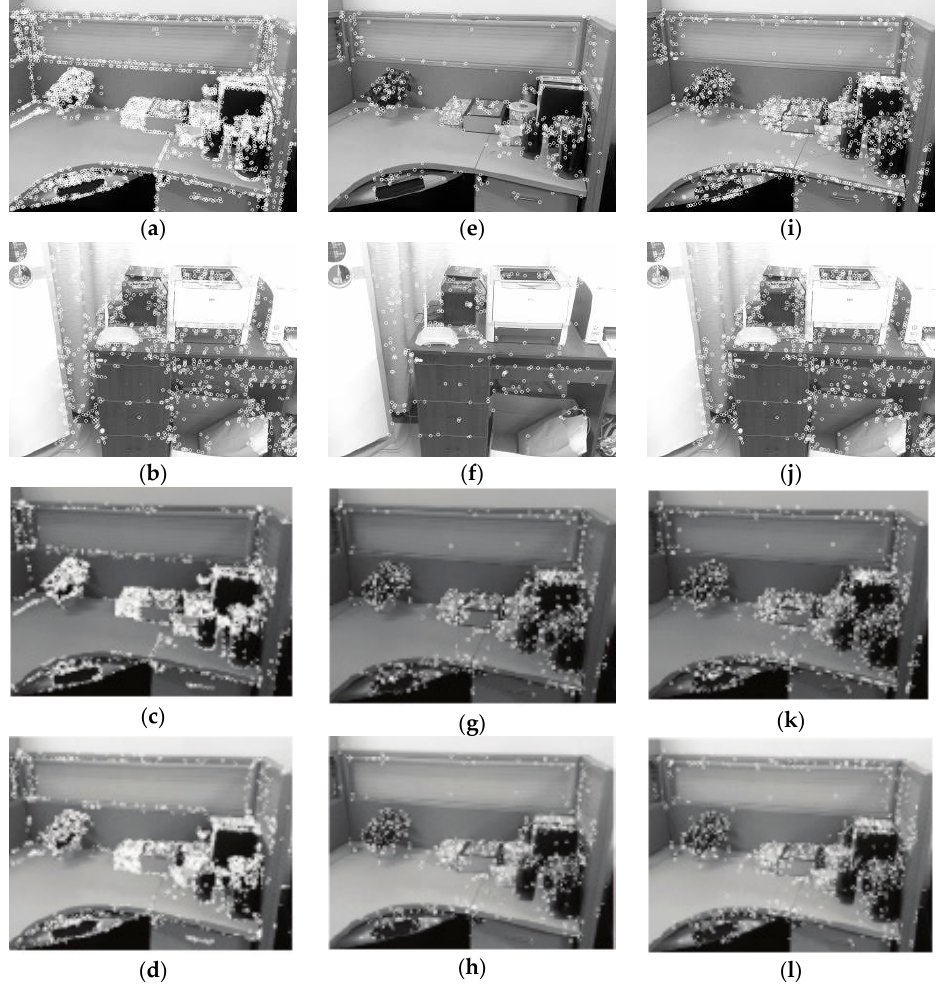
Figure 6. Feature points extracted by each algorithm. ( a – d ) Feature point detection using the Speeded Up Robust Feature (SURF) algorithm; ( e – h ) Feature point detection using the BRISK algorithm; ( i – l ) Feature point detection using BRISK_D algorithm. The first row ( a , e , i ) represents the comparison of the three algorithms with Image A; The second row ( b , f , j ) represents the comparison of the three algorithms with Image B; The third row ( c , g , k ) represents the comparison of the three algorithms with Image C.; The fourth row ( d , h , l ) represents the comparison of the three algorithms with Image